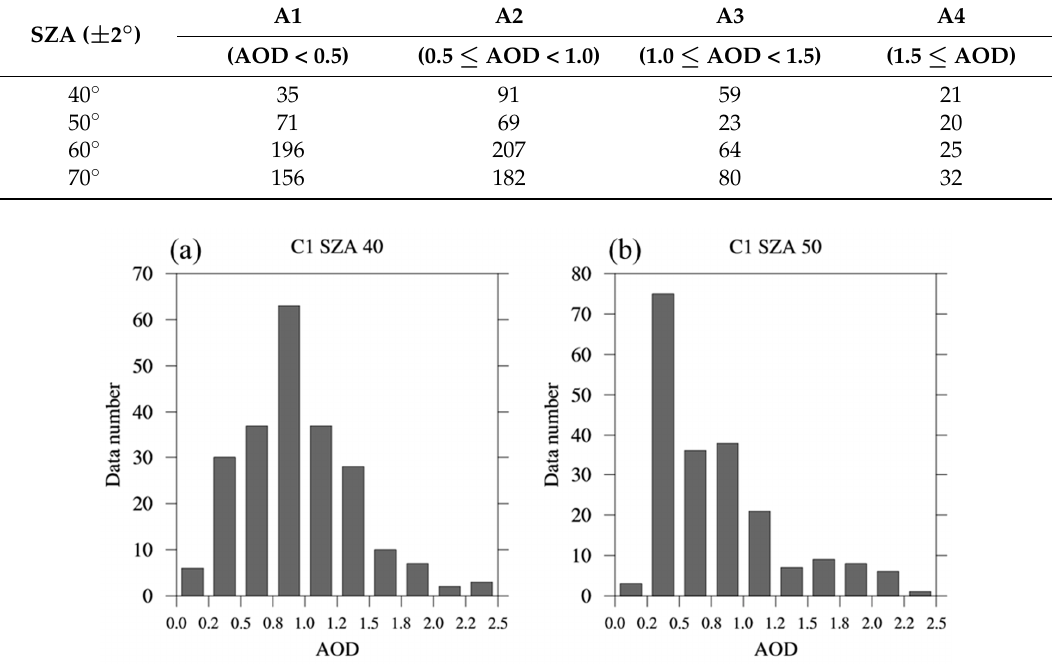
Table 2. Number of observation for aerosol modification factor (AMF) calculation with respect to (SZA) and categories of aerosol optical depth (AOD) during the period of 2006–2010.